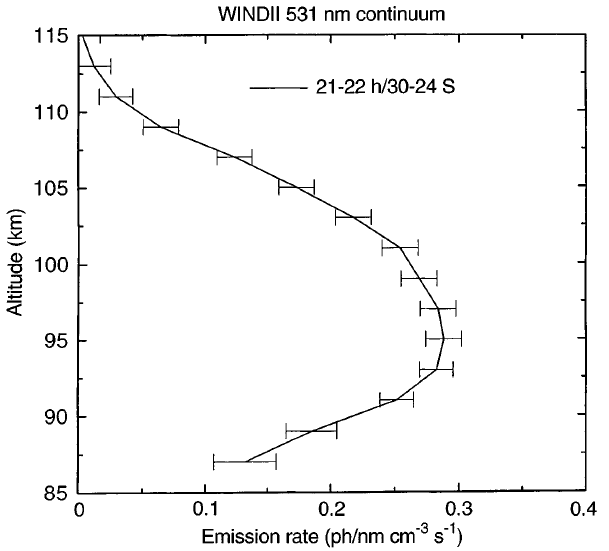
Fig. 4. A contour plot of the atomic oxygen densities derived from the WINDII greenline measurements for the latitude bin 30 (cid:176) S to 24 (cid:176) S as a function of local solar time